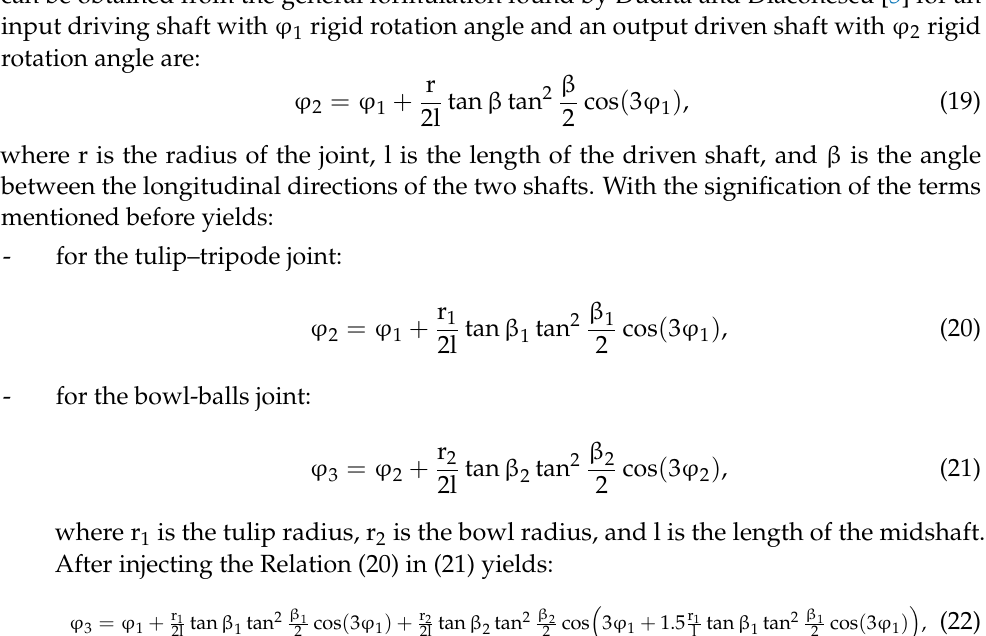
Figure 8. Components of the bowl-balls joint.